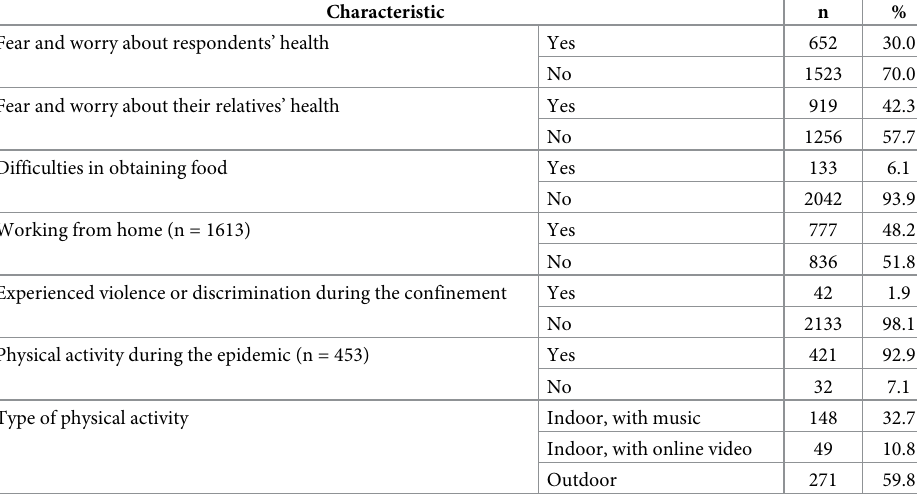
Table 2. Impact of COVID-19 confinement measures on domestic and professional habits. Characteristic n % Fear and worry about respondents’ health